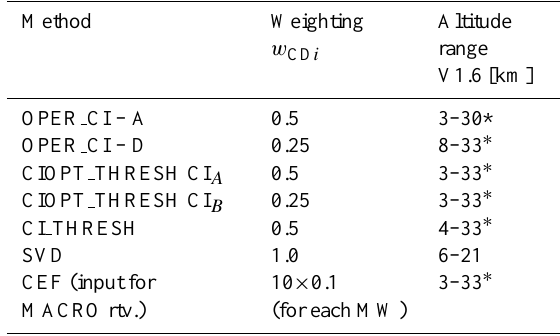
Table 2. Settings of the cloud confidence weighting and correspond- ing altitude range for all cloud detection methods.